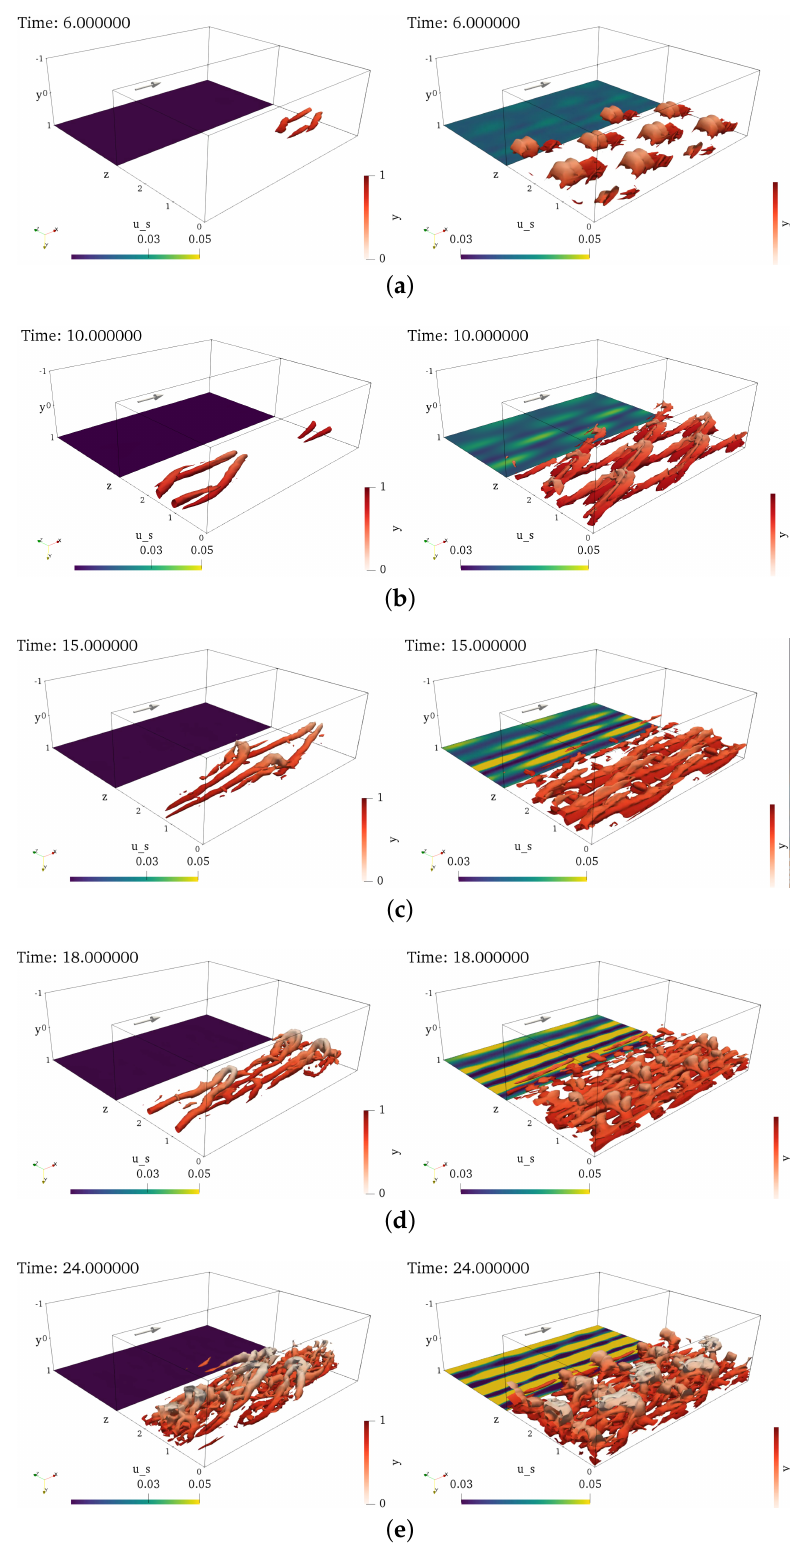
Figure 12. Snapshot of the time evolution of the nonlinear optimal perturbation for T = 10, Re = 4000, E ( 0 ) = 2 10 − 6 for the no-slip (left column) and slippery case with L s = 0.02 (right column), with × the time from panels ( a – e ) indicated within the subframes. For each snasphot, the right box shows isosurfaces of the Q criterion (red) shaded with respect to the wall-normal position of the vortices, whereas the left box shows the iso-contours of the streamwise velocity at the